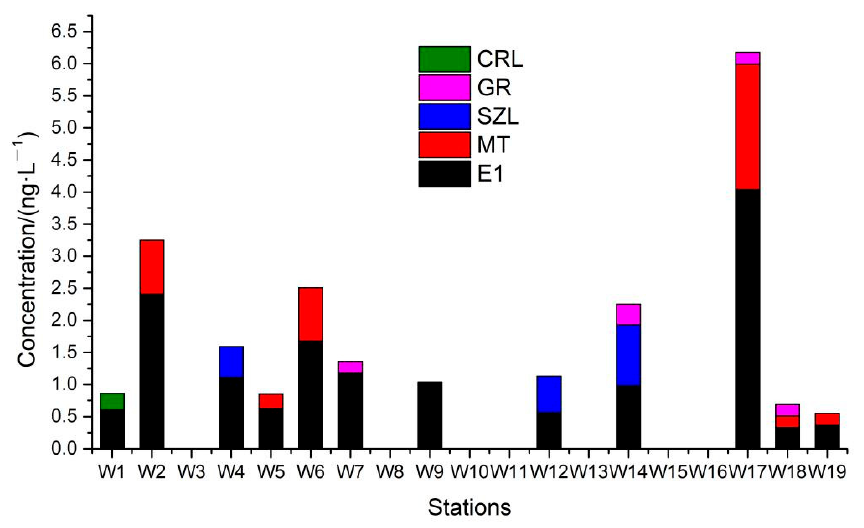
Figure 4. Distribution of steroids in seawater sampling stations.